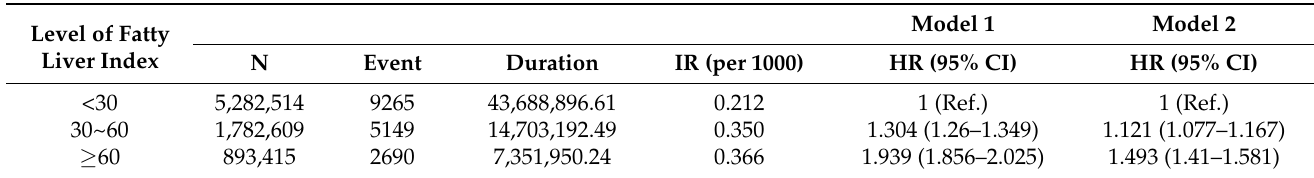
Table 2. Adjusted hazard ratios for the incidence of heart failure according to the level of fatty liver index.